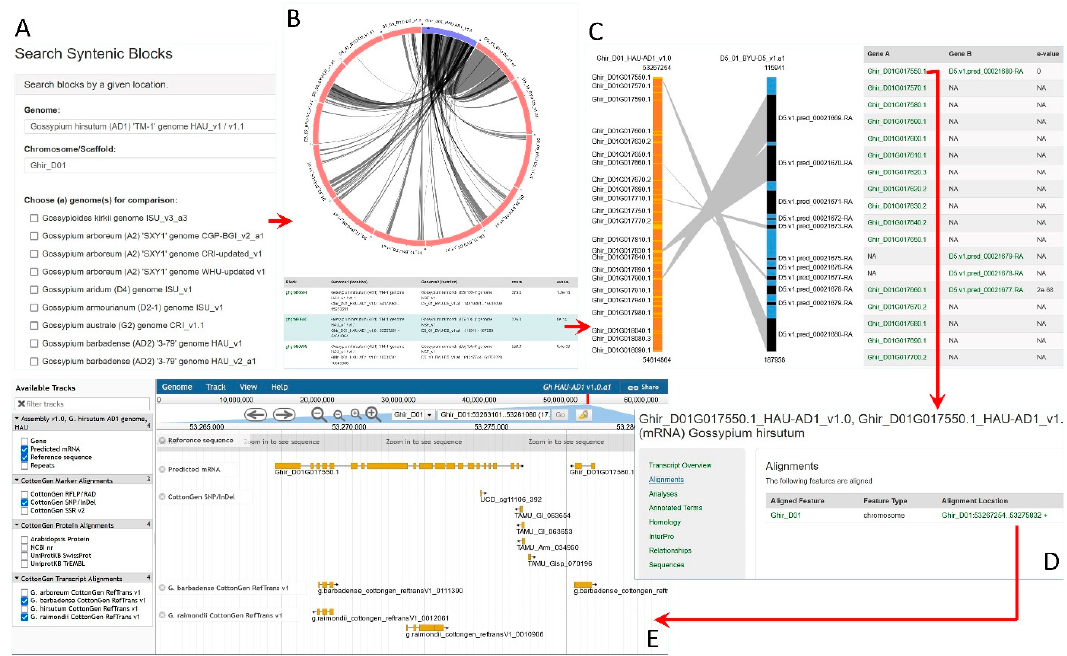
Figure 1. Synteny Viewer in CottonGen. ( A ) Home page of Synteny Viewer allows researchers to choose a chromosome of agenome and multiple genomes for comparison. Researchers can also choose a synteny block ID. ( B ) A circular diagram and a table shows the synteny blocks between a chromosome of a reference genome and all chromosomes of another genome being compared. ( C ) A bar diagram and a table that shows all the genes in a syntenic block. The table displays E-value between the matching genes and the gene names have hyperlinks to the gene detail page. ( D ) A gene detail page with a resource side bar and the hyperlink to JBrowse. ( E ) JBrowse around the mRNA of interest with tracks such as gene, mRNA, SNP and SSR markers.